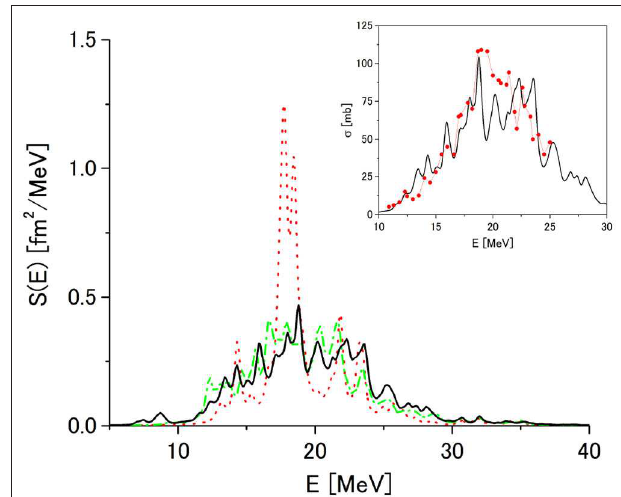
FIGURE 8 | Strength functions calculated in RPA (dotted line), SRPA (dot-dashed line) and ERPA (solid line) for the isovector dipole excitation in 48 Ca. The distributions are smoothed with an artificial width Ŵ the inset the photo absorption cross section in ERPA (solid line) is compared with experimental data [52] (dots). Readapted from Tohyama [36] under the Creative Commons CCBY license.